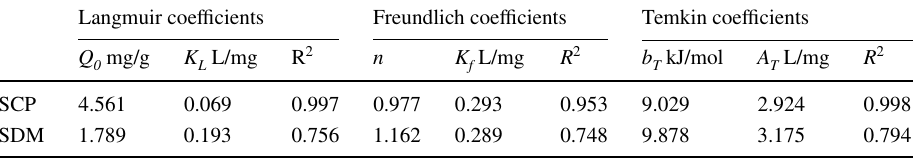
Table 6 Calculated adsorption isotherm values using nonlinear regression